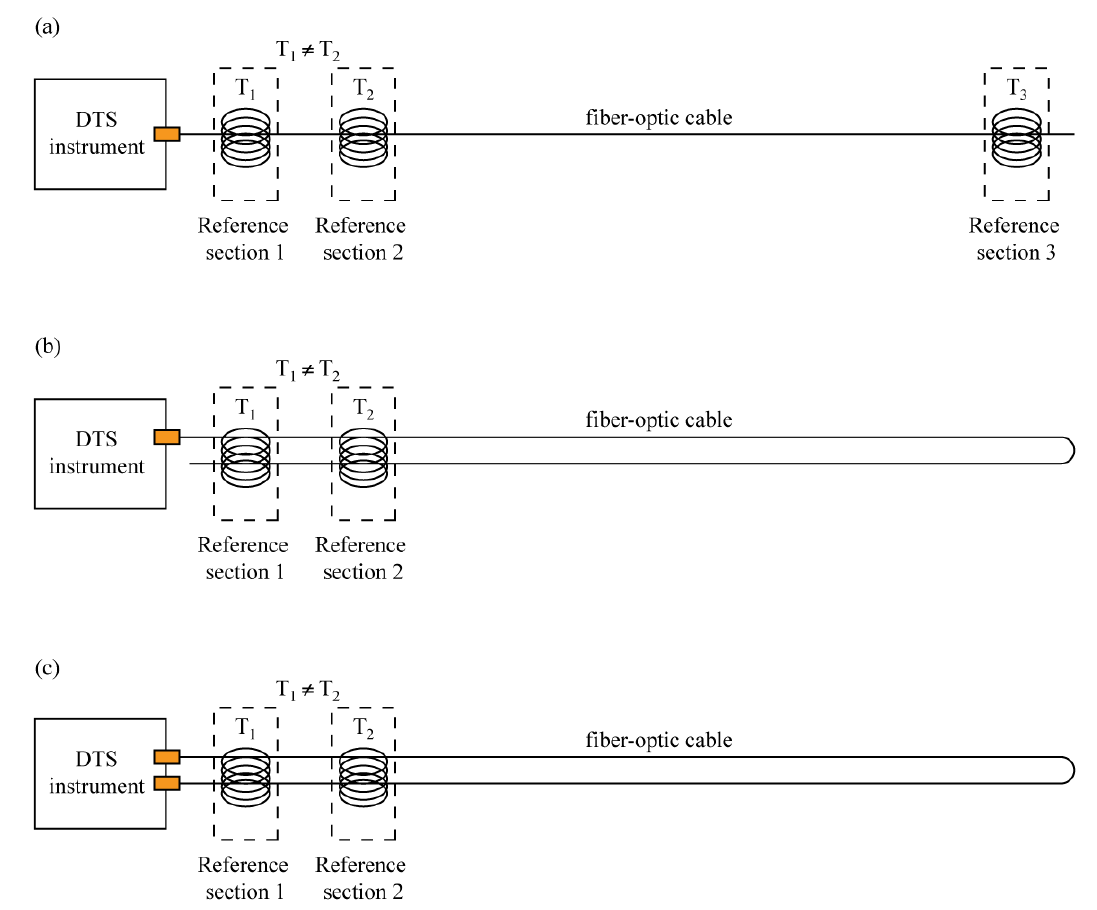
Figure 1. Typical DTS experimental designs. (a) Simple single-ended configuration; (b) Duplexed single-ended configuration; (c) Double-ended